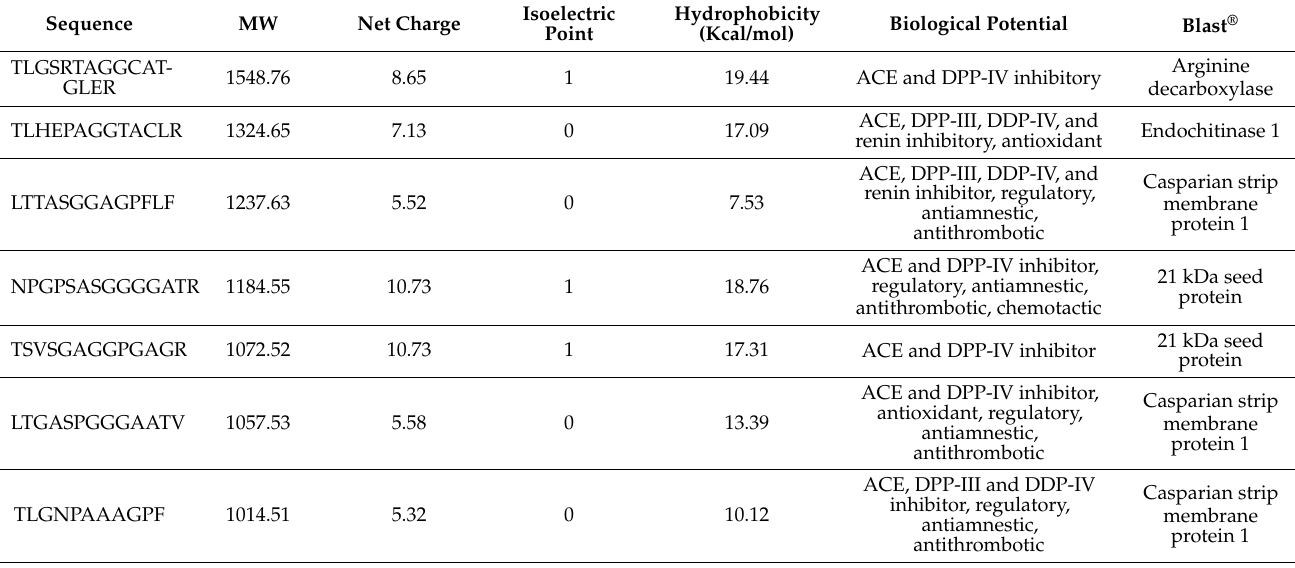
Table 2. Peptide sequence of Criollo cocoa obtained from in vitro